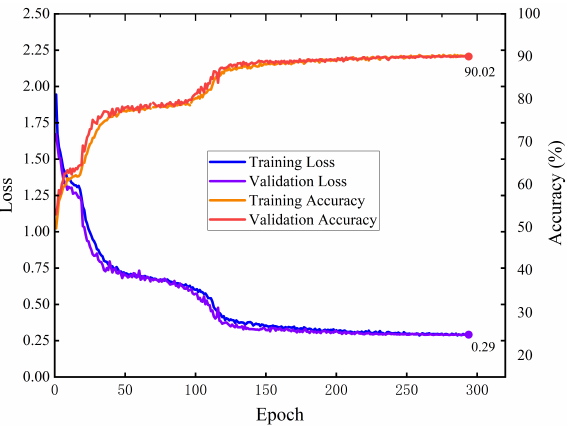
Figure 7. Training curves of LSTM2 with SigAugment-R on the 2016A-50 dataset.